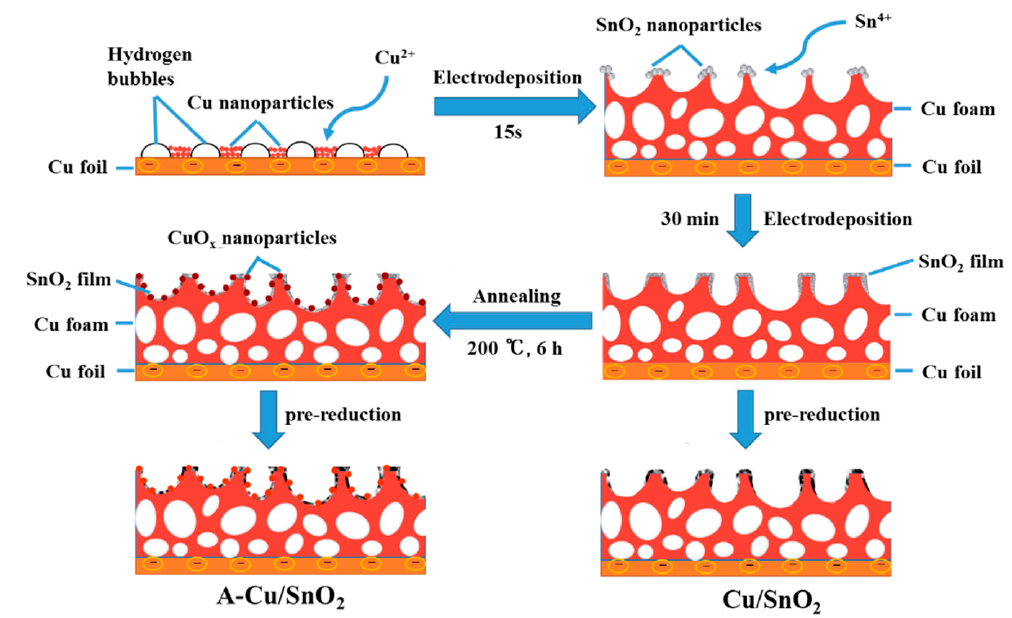
Figure 1. Schematic drawing of the fabrication of Cu / SnO 2 and A-Cu / SnO 2 . The SEM images at each stage for Cu / SnO 2 and A-Cu / SnO 2 are shown in Figure 2 and Figures S1–S3. The three-dimensional dendritic Cu foam (Figure S1) with about 40 um pore size was successfully constructed, which could provide a large electrochemical surface area [5]. After depositing SnO 2 layer on Cu foam (Figure 2a) and then performing pre-reduction, the resultant Cu / SnO 2 electrode (Figure 2b) ideally maintains the porous structure and shows a thin layer consisting of numerous packed flakes covering the original copper dendrites. The cross-sectional view (Figure S2) indicates that the thickness of Cu foam and deposited SnO 2 layer on Cu foil is 60–70 um. Furthermore, through above procedure but adding an annealing step before pre-reduction, A-Cu / SnO 2 electrode was obtained. Figure 2c,d show the morphology for A-Cu / SnO 2 at the stage of annealing and pre-reduction, respectively. Obviously, A-Cu / SnO 2 displays the same porous structure, but with a significant increase of Cu atoms on the surface (EDS: 76.5%, 78.4%) compared with Cu / SnO 2 (EDS: 66.2%, 66.7%). In addition, the SEM elemental mapping of Cu and Sn for the Cu / SnO 2 electrode before and after pre-reduction (Figure S3a and Figure 2e) reveals that SnO 2 is mainly electrodeposited on the outer Cu walls of the porous structure, forming a connecting film on the surface. Whereas, from the SEM elemental mapping of A-Cu / SnO 2 at the stage of annealing and pre-reduction (Figure S3b and Figure 2f), it can be seen that Sn atoms distribute both inward pores and the outward pores, indicating the re-distribution of SnO 2 during preparation. Besides this, ICP-AES results for Cu / SnO 2 and A-Cu / SnO 2 (Table S1) reveals that there is no missing Sn atom due to annealing treatment. Together with above results, we could speculate that there is a significant migration of Cu and Sn atoms for the A-Cu / SnO 2 electrode due to annealing, leading to the enrichment of Cu atoms and a decrease of Sn atoms on the surface, which is also confirmed by XPS analysis (Table S2). Moreover, the structure of the deposited SnO 2 film (inset images of Figure 2a–c) shows that there is a slight breakage of SnO 2 film after annealing treatment, which might be caused by the formation of copper oxides as well as migration of SnO 2 inward to the